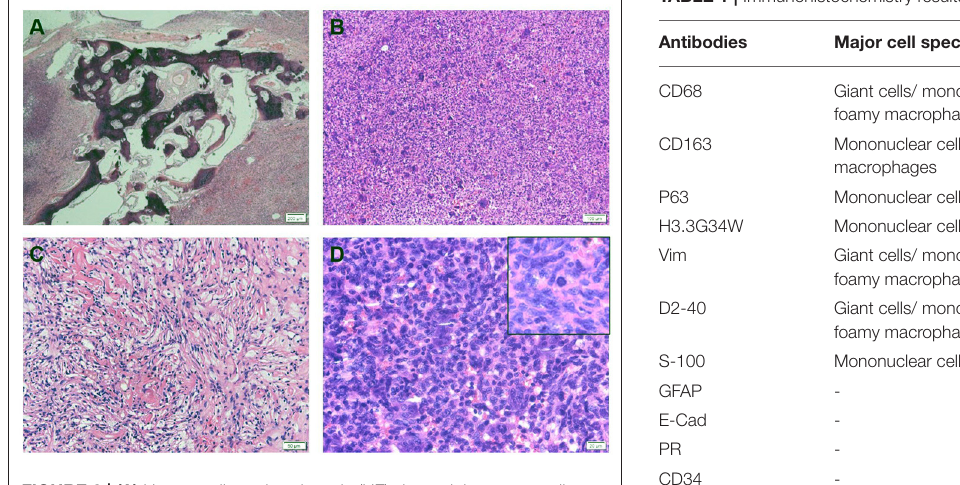
FIGURE 2 | (A) Hematoxylin and eosin stain (HE) showed that tumor cells invade bone tissue. (B) Tumor tissue consists of mononuclear cells and a large number of evenly distributed osteoblast-like cells. (C) A histological pattern of benign fibrous histiocytoma can be seen, with more foam-like cells. (D) The nuclear morphology of osteoblast-like multinucleated giant cells is similar to that of mononuclear cells, and nuclear division images are visible (upper right corner).